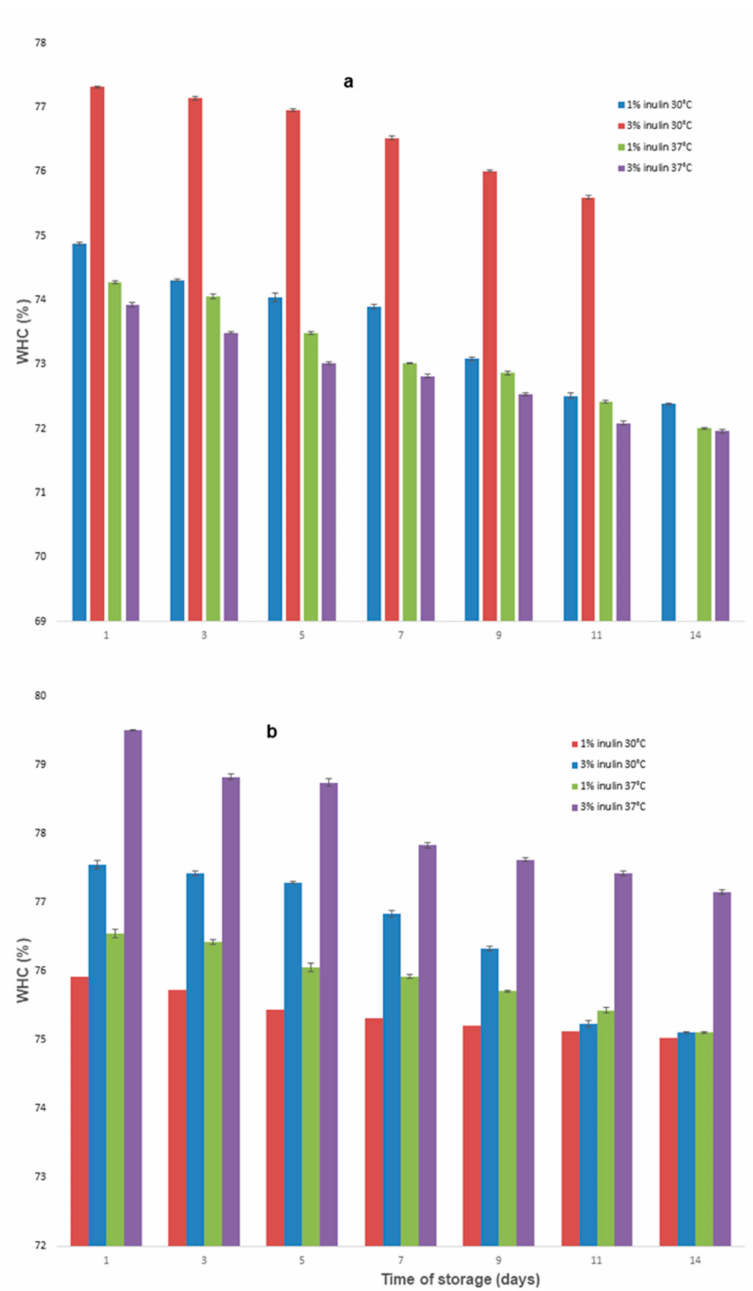
Figure 7. Variations in WHC of the beverages during storage. ( a ) Samples with SBS; ( b ) Samples with